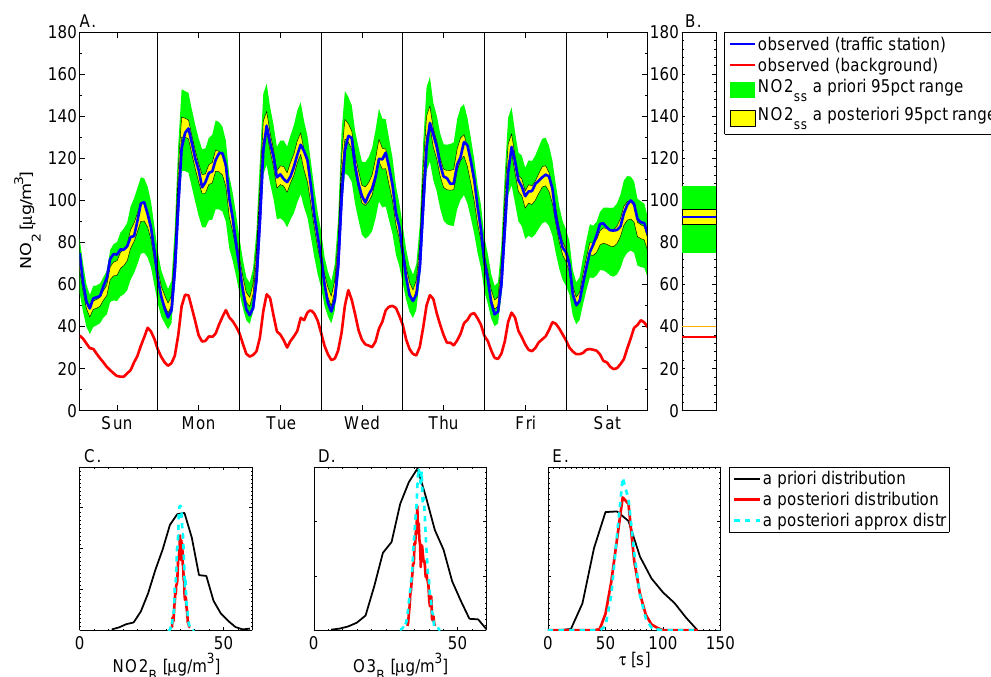
Fig. 5. Parameter estimation from the annual average weekly pattern of observations at Landshuter Allee traffic station, Munich. (A) Weekly pattern of observed roadside (blue) and background (red) NO 2 concentrations in 2009, the 95 percentile range of explained concentrations with a priori input parameter distributions (green area), and the 95 percentile range of concentrations modelled with a posteriori parameter distributions after the estimation process (yellow). (B) Average of concentrations shown in (A) over all hours of the week, corresponding to the annual average. (C–E) Distributions of involved input quantities before (black) and after (red) the parameter estimation, and the approximation of the latter by normal (log-normal in the case of τ ) distributions (cyan, dashed). For ease of viewing, distributions in (C–E) are not